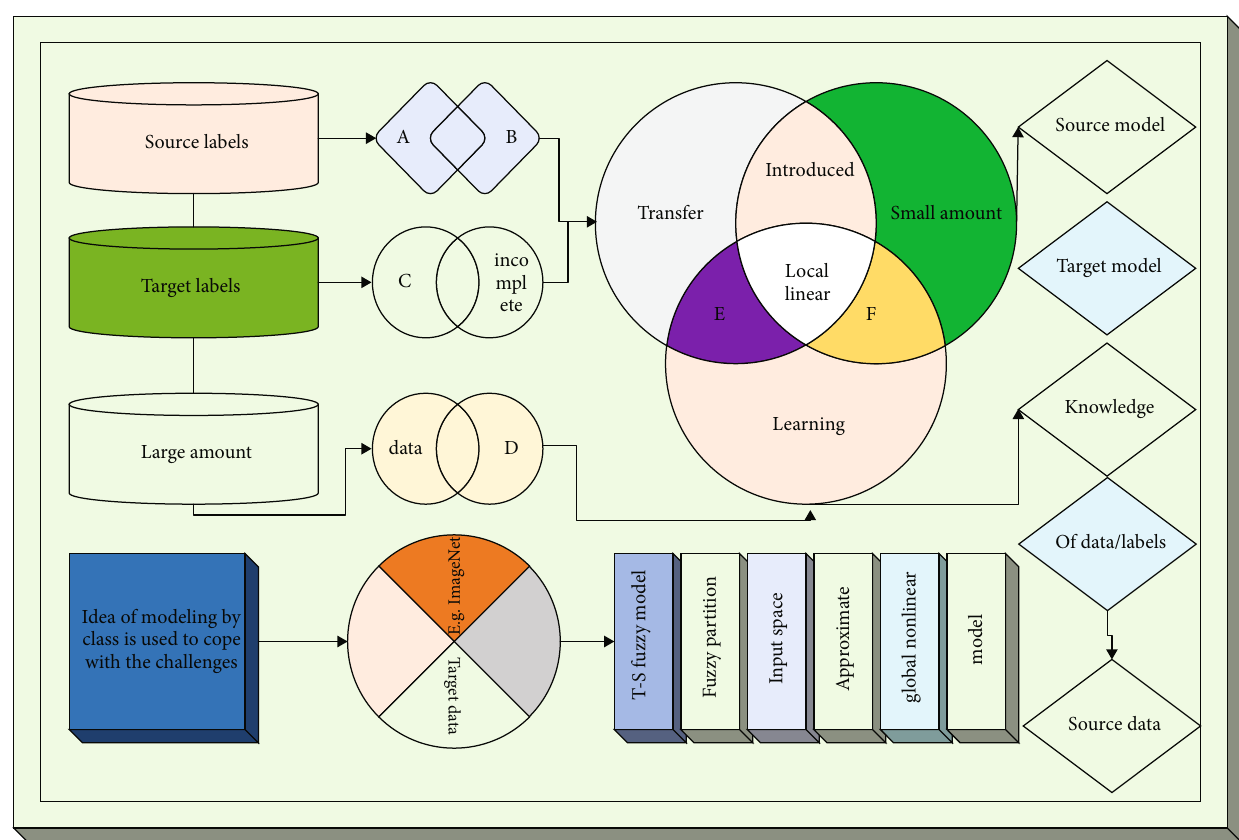
Figure 1: Framework of attribute modelling and knowledge acquisition image recognition